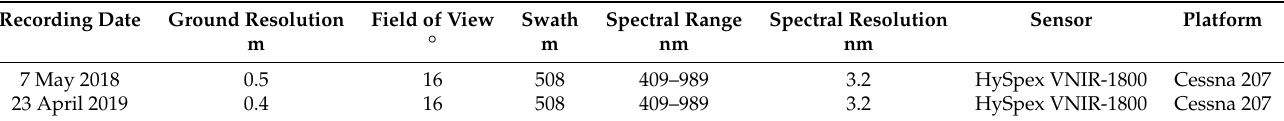
Table 1. Specification of the hyperspectral sensor used for image